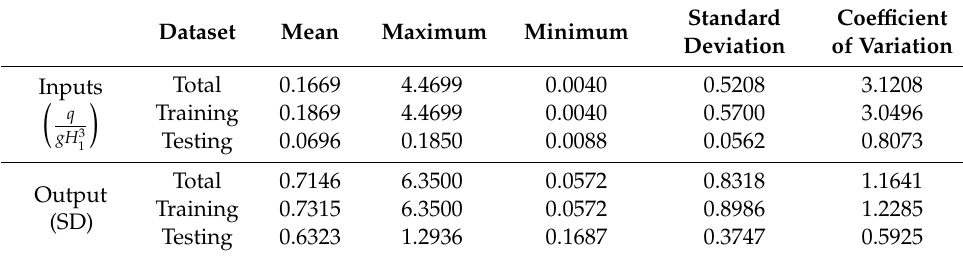
Table 2. Statistical parameters of data.